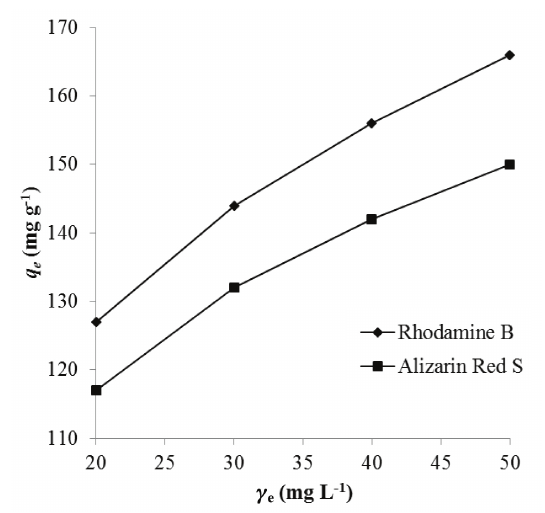
Fig. 5 – Effect of equilibrium concentration of each dye on adsorption capacity (γ